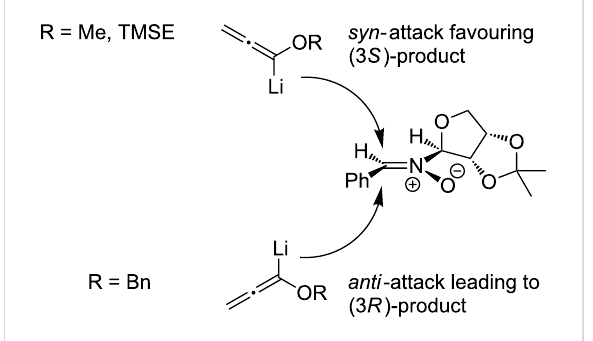
Figure 3: Model proposed for the addition of lithiated allenes to nitrone 1a .